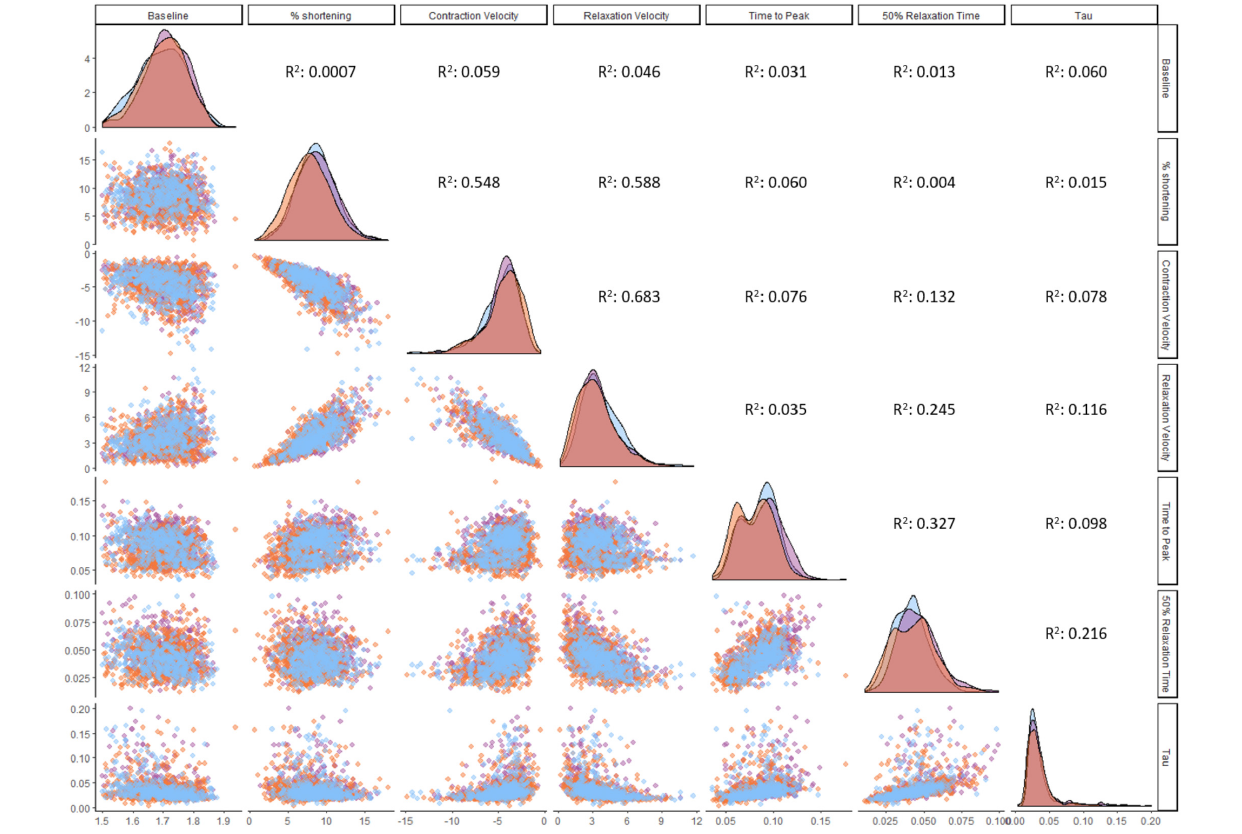
FIGURE 5 | Correlations between contractility parameters. Correlation analysis was performed on ventricular cardiomyocytes ( n = 1,771). Distribution plots and individual cardiomyocytes are colored based on their origin: RV (orange), LV (purple), and IVS (blue). All correlations with an R 2 larger than 0.01 are statistically significant at the level of p <